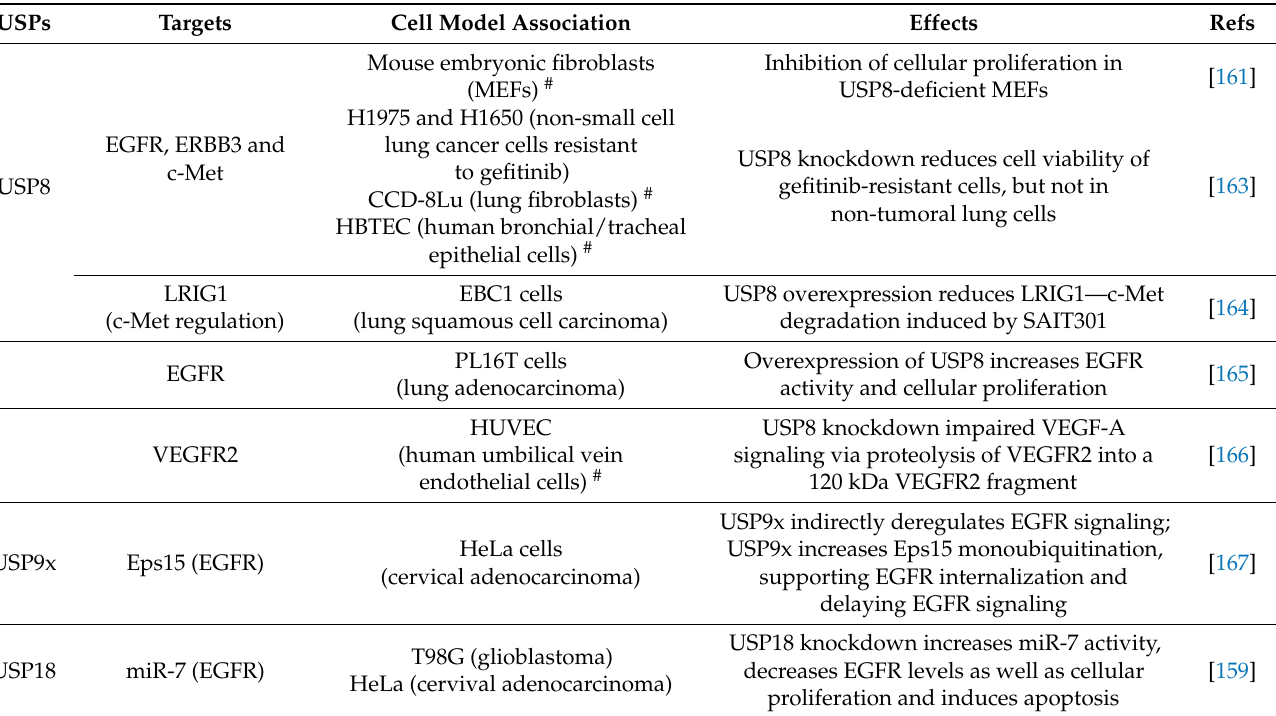
Table 6. Summary of cellular consequences resulting from interactions between different USPs and target proteins associated with receptor tyrosine kinases signaling